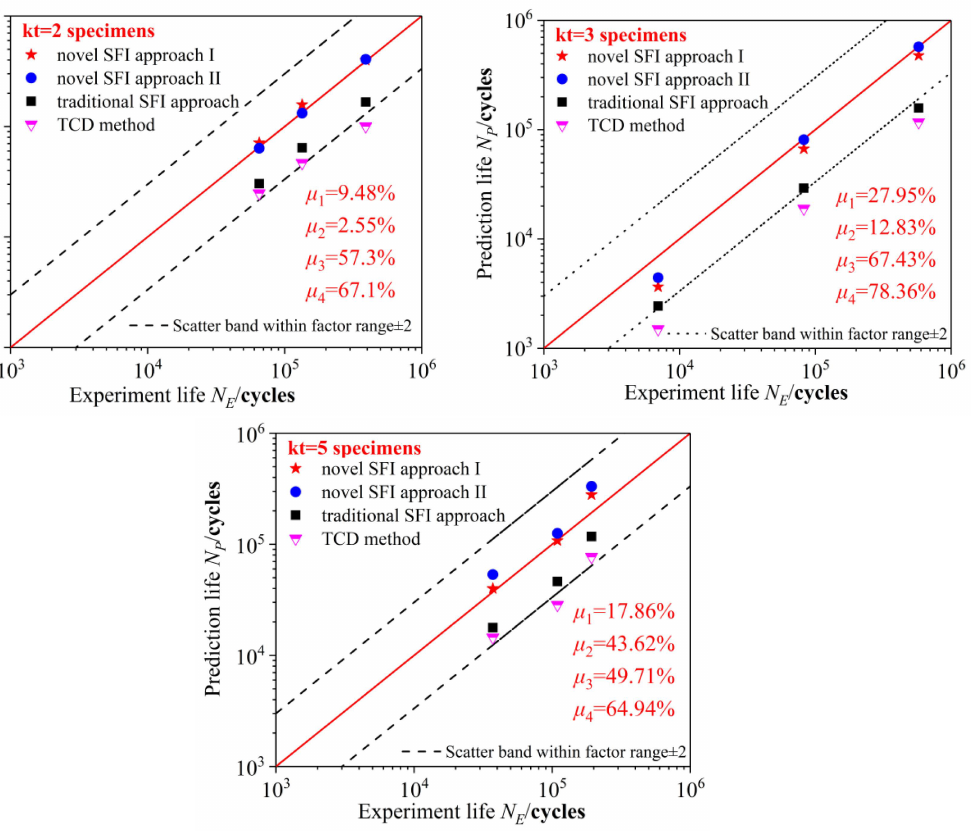
Figure 15. Index parameters of notched specimens calculated by four different